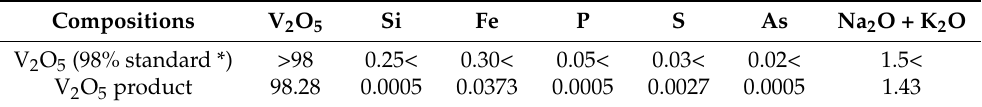
Table 2. Chemical compositions of the standard and the V 2 O 5 product (wt.%).